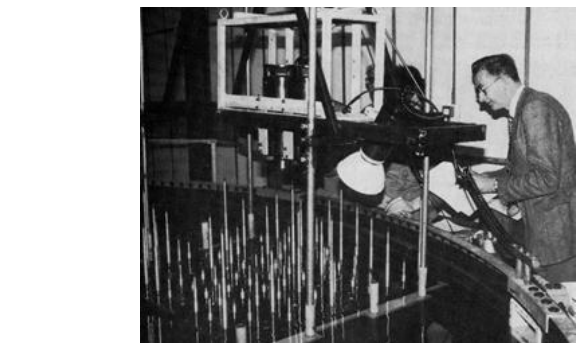
Figure 2. The ideal geometry for a self-calibration network.